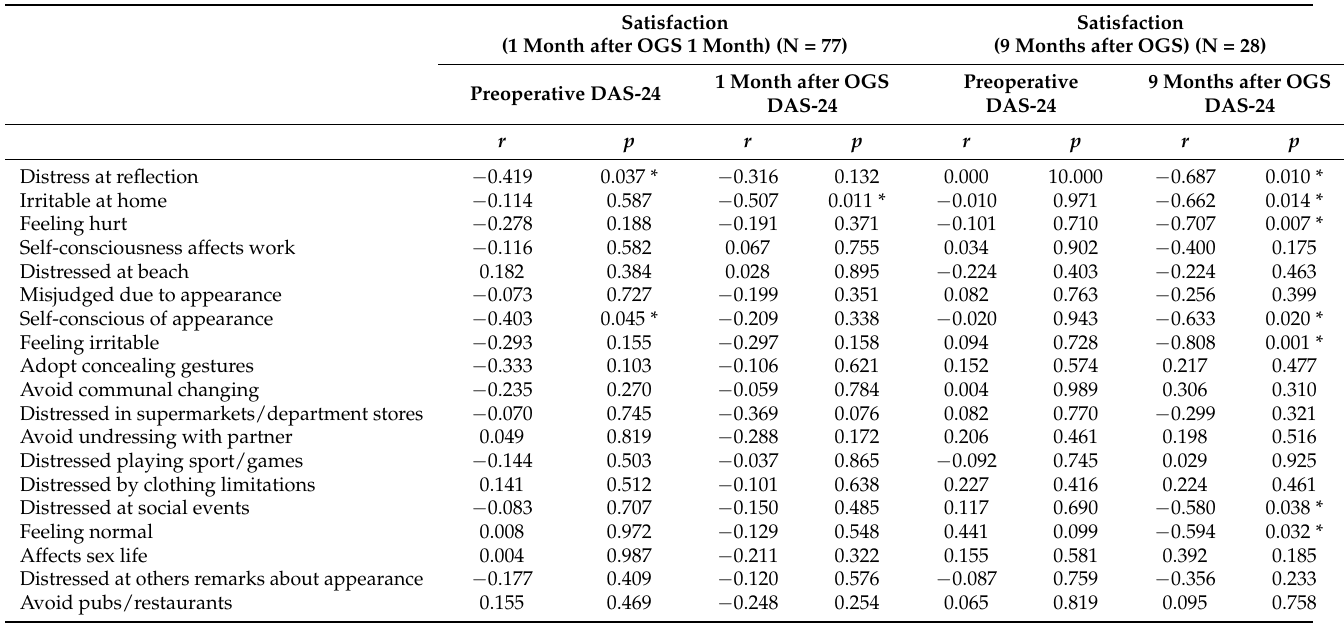
Table 3 shows that preoperative distress at reflection ( r = − 0.419, p = 0.037), conscious- ness of appearance ( r = − 0.403, p = 0.045), and one-month postoperative irritability at home (( r = − 0.507, p = 0.011) were related to satisfaction one month after OGS. Nine-month postoperative distress at reflection ( r = − 0.687, p = 0.010), irritability at home ( r = − 0.662, p = 0.014), feeling hurt ( r = − 0.707, p = 0.007), self-conscious of appearance ( r = − 0.633, p = 0.020), feeling irritable ( r = − 0.808, p = 0.001), distress at social events ( r = − 0.580, p = 0.038), and feeling normal ( r = − 0.594, p = 0.032) were all related to satisfaction nine months after OGS. Table 3. Correlation between DAS-24 (preoperative, 1 month and 9 months after OGS) and surgical satisfaction.